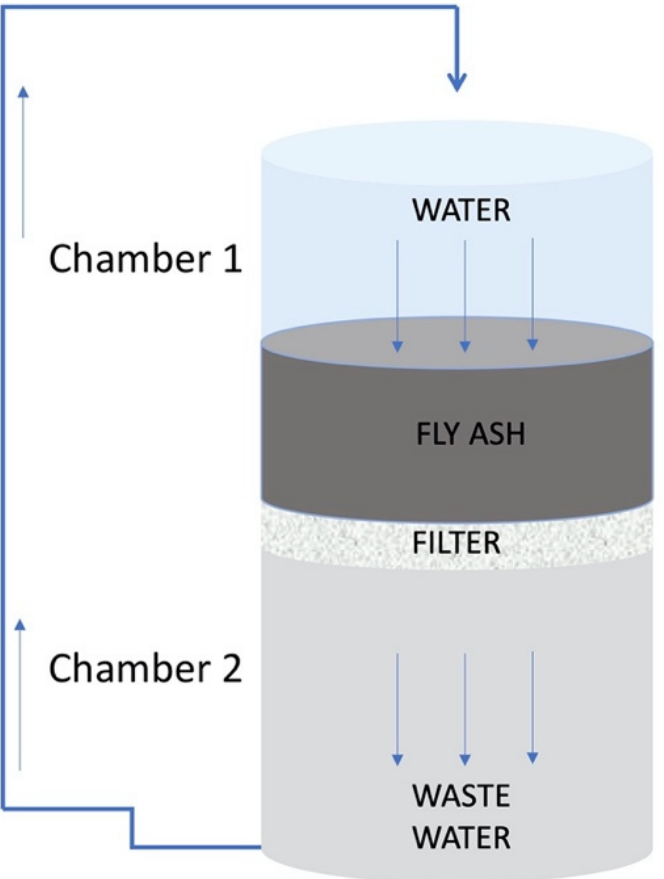
Figure 1. Scheme of the multi-step water